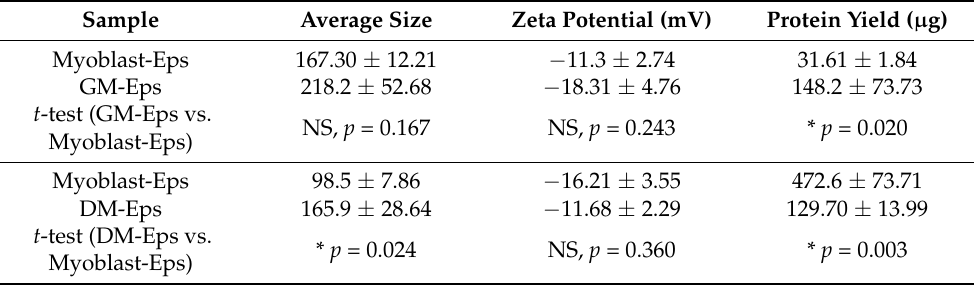
Table 1. Average size, zeta potential and protein yield of EPs isolated from myoblasts (MB) and myotubes (MT) and their respective media-only conditions. C2C12 myoblasts were cultured in growth media (GM) made from DMEM containing 10% fetal bovine serum (FBS) and 1% antibiotics. To differentiate myoblasts into myotubes, media was switched to differentiation media (DM): DMEM supplemented with 5% horse serum (HS) and 1% antibiotics. FBS and HS can contain EVs from bovine or horse serum, respectively. To evaluate the confounding effect of the serum (if any), EPs were isolated using Total Exosome Isolation Reagent (ThermoFisher, Waltham, MA, USA) from GM- only conditions and compared to myoblast-EPs, and from DM only and compared to myotube-EPs ( n = 3–6, * p < 0.05). Results were analyzed using an unpaired Student’s t test. Data are expressed as mean ± standard error. Sample Average Size Zeta Potential (mV) Protein Yield ( µ g) Myoblast-Eps 167.30 ± 12.21 − 11.3 ± 2.74 31.61 ± 1.84 GM-Eps 218.2 ± 52.68 − 18.31 ± 4.76 148.2 ± 73.73 t -test (GM-Eps vs. NS, p = 0.167 NS, p = 0.243 * p = 0.020 Myoblast-Eps) Myoblast-Eps 98.5 ± 7.86 − 16.21 ± 3.55 472.6 ± 73.71 DM-Eps 165.9 ± 28.64 129.70 ± 13.99 t -test (DM-Eps vs. * p = 0.024 NS, p = Myoblast-Eps)